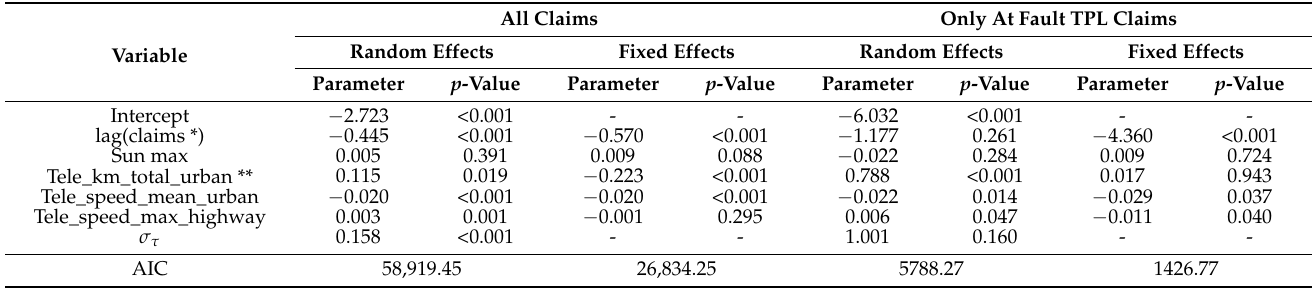
Table A5. Cross-table with the parameter estimates of random effects and fixed-effects Poisson panel data models, with p -values, for the total number of claims (left) and at-fault third party liability (TPL) claims (right) per month and per insured based on the seven observed months in 2018 and 2019. The models consider the monthly maximum daily average of sunshine hours as explanatory variable describing weather conditions.